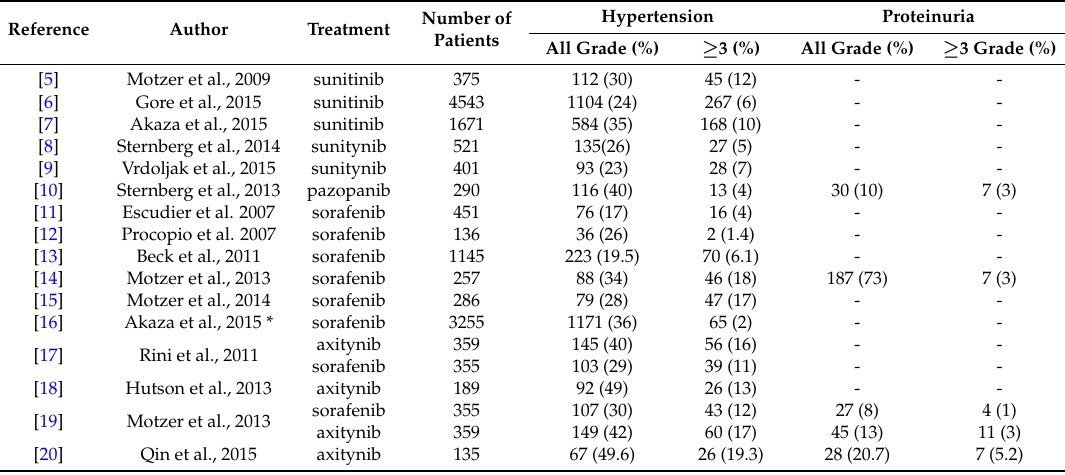
Table 2. Incidence of the tyrosine-kinase inhibitors (TKI) targeted therapy-associated hypertension and proteinuria in phase III/IV clinical